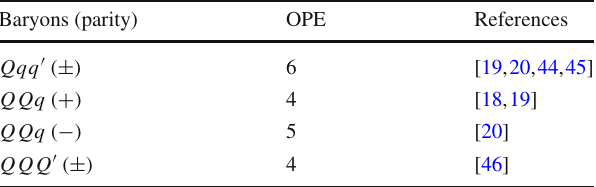
Table 1 The truncations in the operator product expansion (OPE) in theQCDsumrulesfortheheavy,doubly-heavyandtriply-heavybaryon states Baryons (parity)